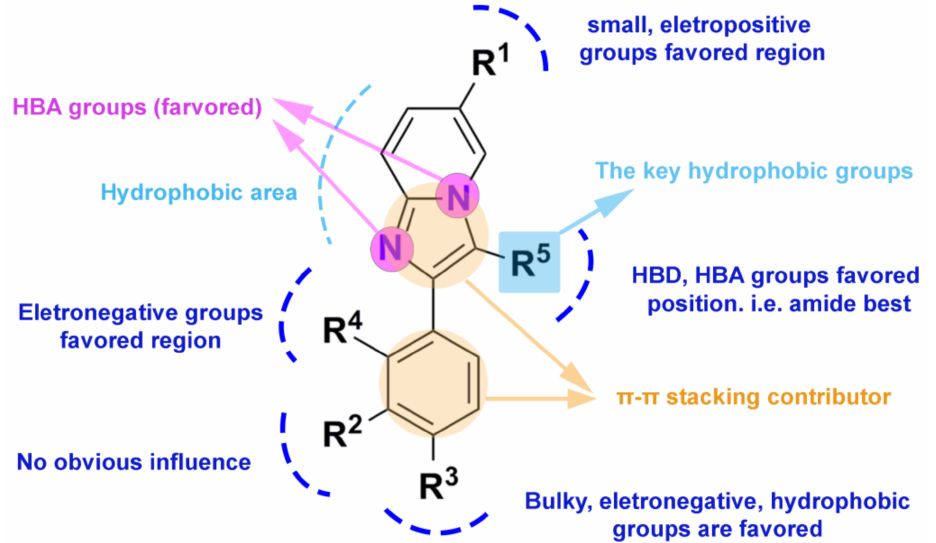
Figure 10. The SARs of imidazo [1,2-a]-pyridine derivatives as GABA A R PAMs based on the 3D-QSAR models, molecular docking results, and the best pharmacophore